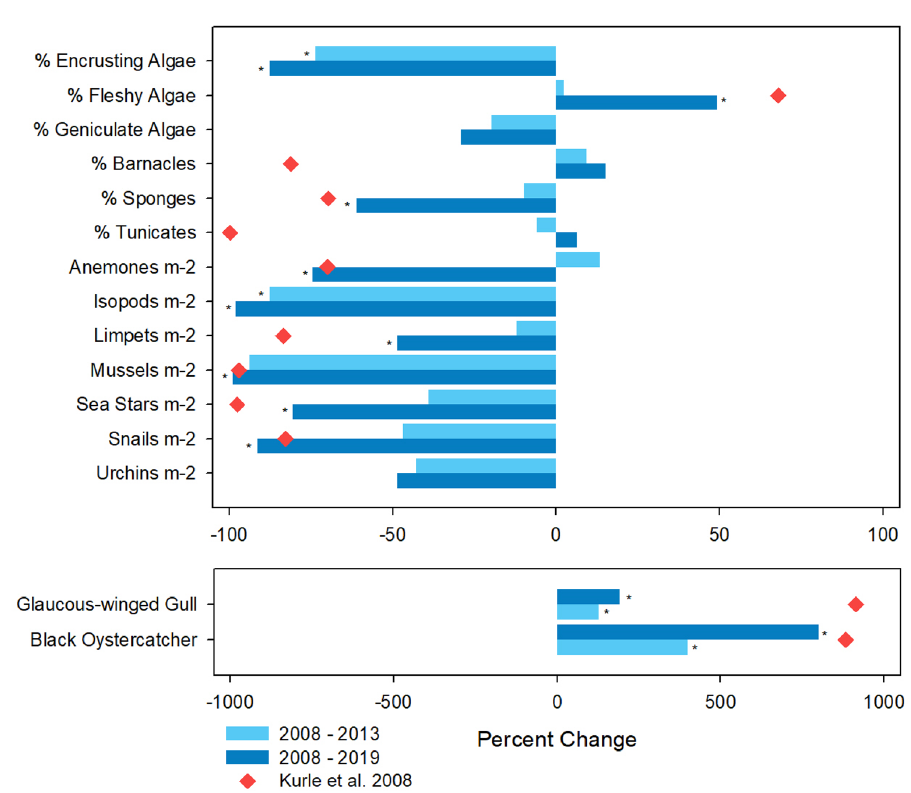
Figure 3. The percent change in algal, barnacle, sponge, and tunicate percent cover and mean number per m 2 of invertebrates pre- vs. post-eradication (2008 vs. 2013 and 2019) measured from intertidal photo quadrats. * indicates significantly different data between 2008 and 2013 or 2008 and 2019, p < 0.05. The red diamonds indicate the percent change between islands with rats and without rats from Kurle et al. 12 . No red diamond indicates an organism that was not measured in Kurle et al. 12